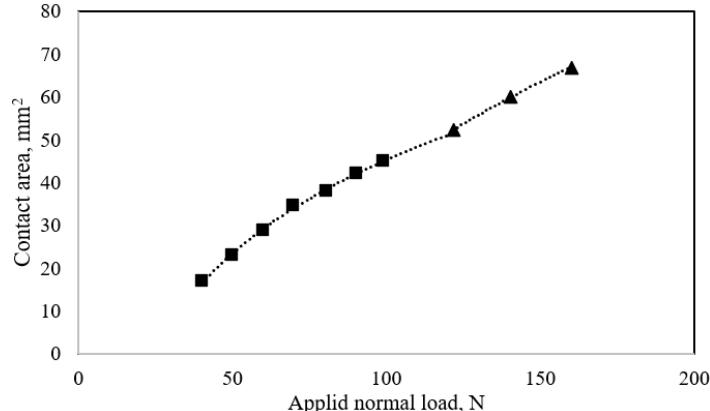
Figure 9. Rubber-wheel real contact area due to applied load for static condition.